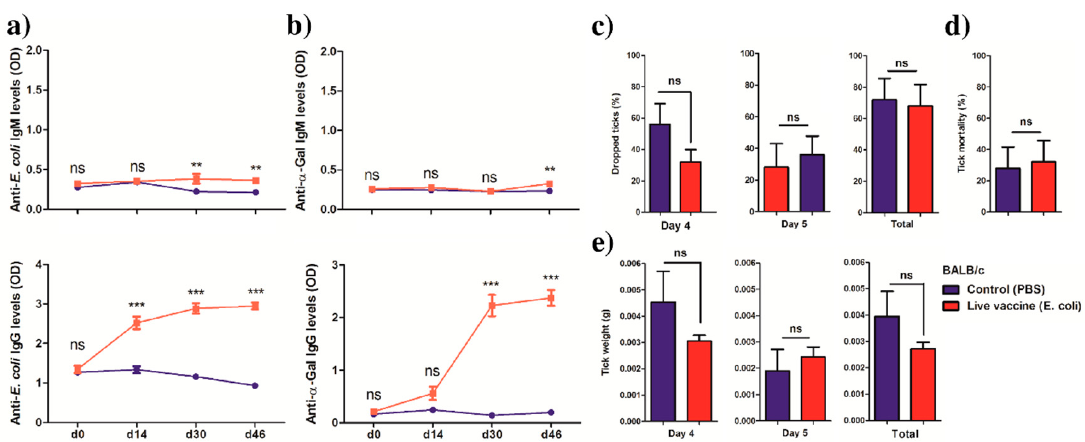
Figure 6. Antibody response of BALB/c mice and tick performance after E. coli immunization. The levels of IgM and IgG levels to ( a ) E. coli proteins and ( b ) α -Gal were quantified in sera by ELISA. ( c ) The percentage of ticks that dropped on days 4 or 5, and the total, were calculated and compared between groups. ( d ) The percentage of dead ticks was calculated and tick mortality (%) compared between groups. ( e ) At the end of the feeding, the weight of individual ticks was measured and compared between groups. Means, standard error ( a , b ) and standard deviation (c – e) values are shown. Results were compared by two-way ANOVA with Bonferroni multiple comparison test applied for individual comparisons (ELISA) and Mann − Whitney U test (tick performance). (** p < 0.001, *** p < 0.0001; ns—not significant; 1 experiment, n = 10 mice ( n = 5 ticks per mouse) and three technical replicates per sample (ELISA).